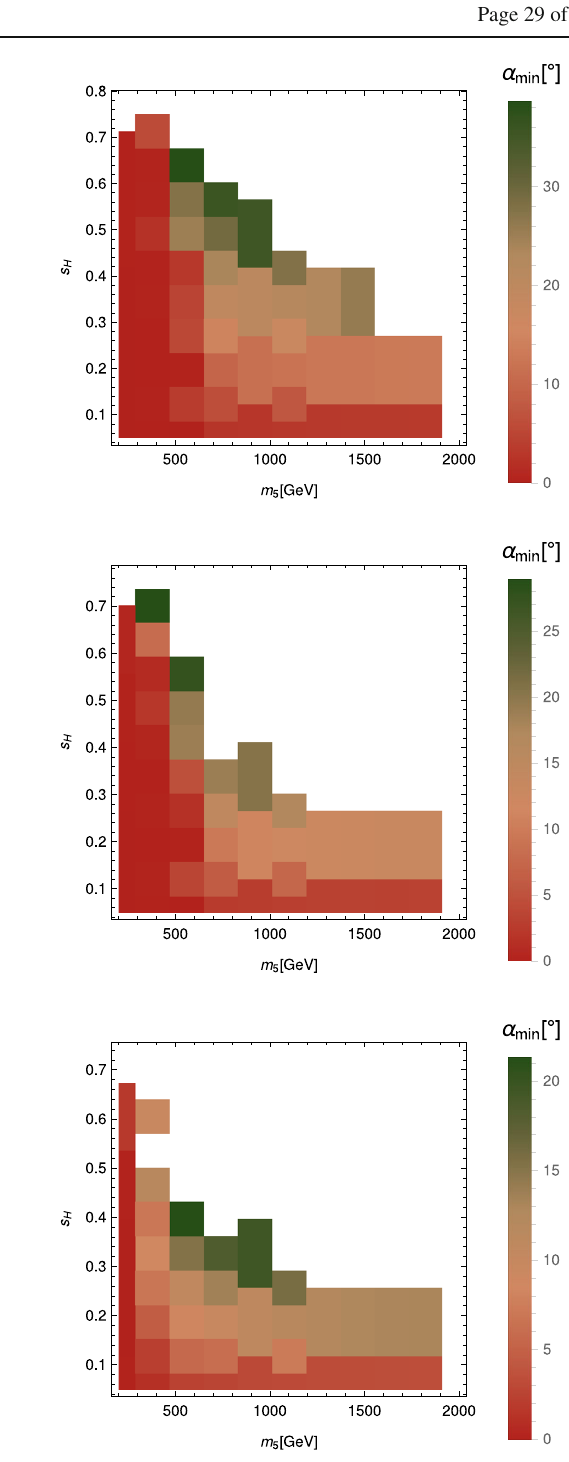
after applying the HiggsBounds cuts, and in the third row after both HiggsBounds and weak perturbativity cuts